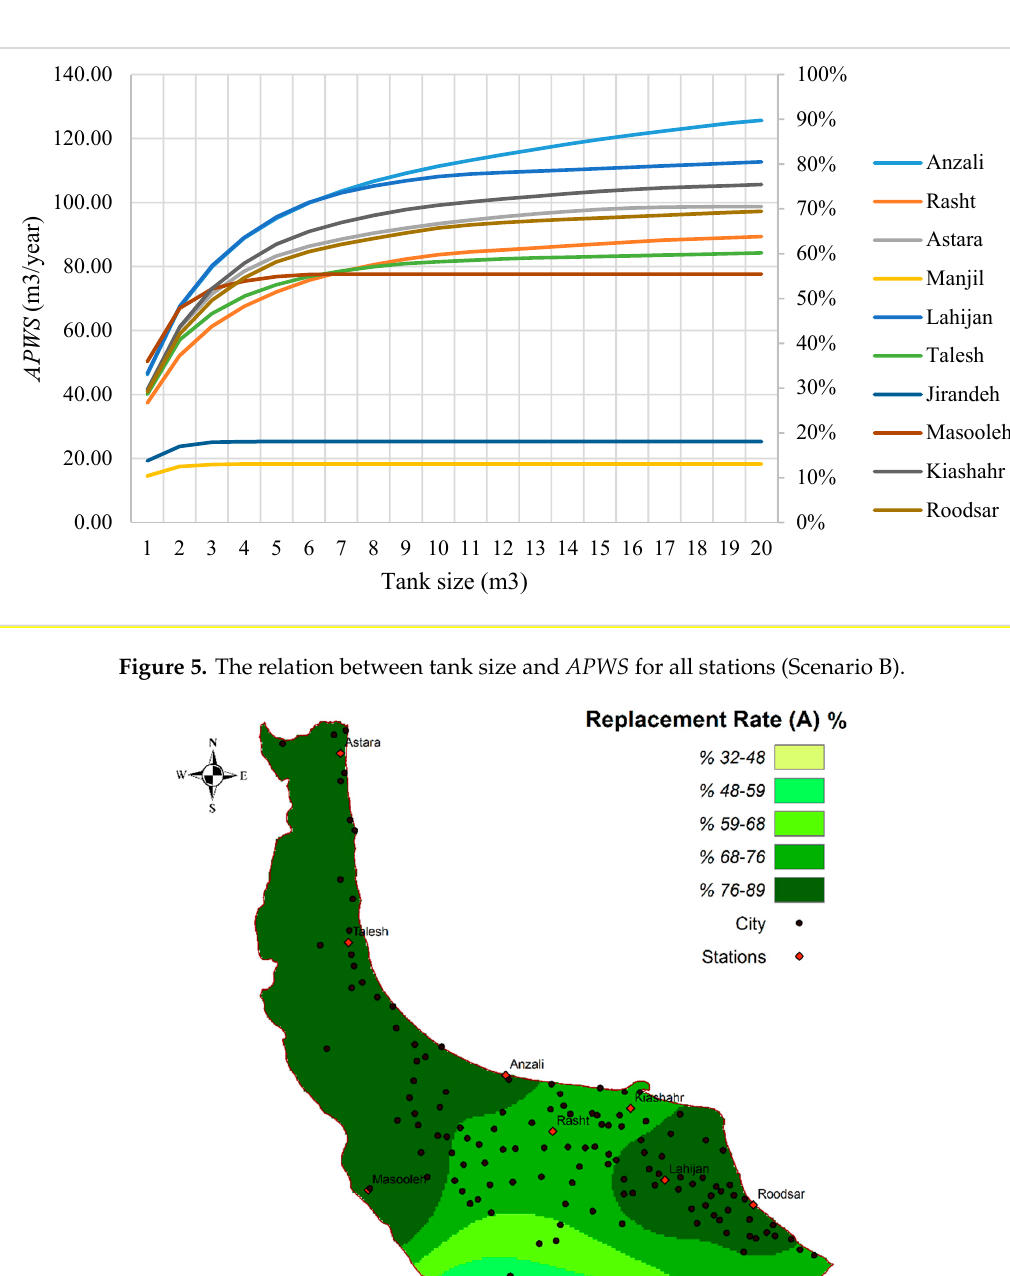
Figure 4. The relation between tank size and APWS for all stations (Scenario A).